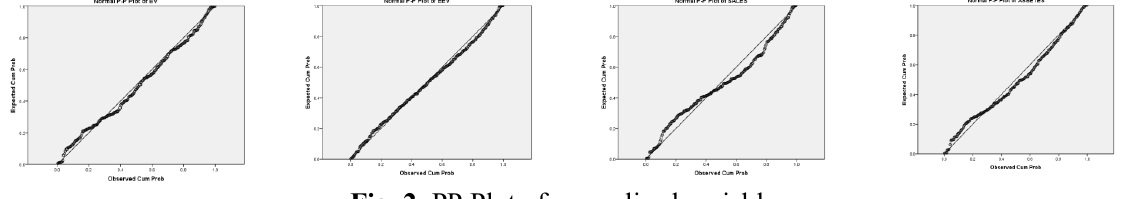
Fig. 2. PP Plot of normalized variables